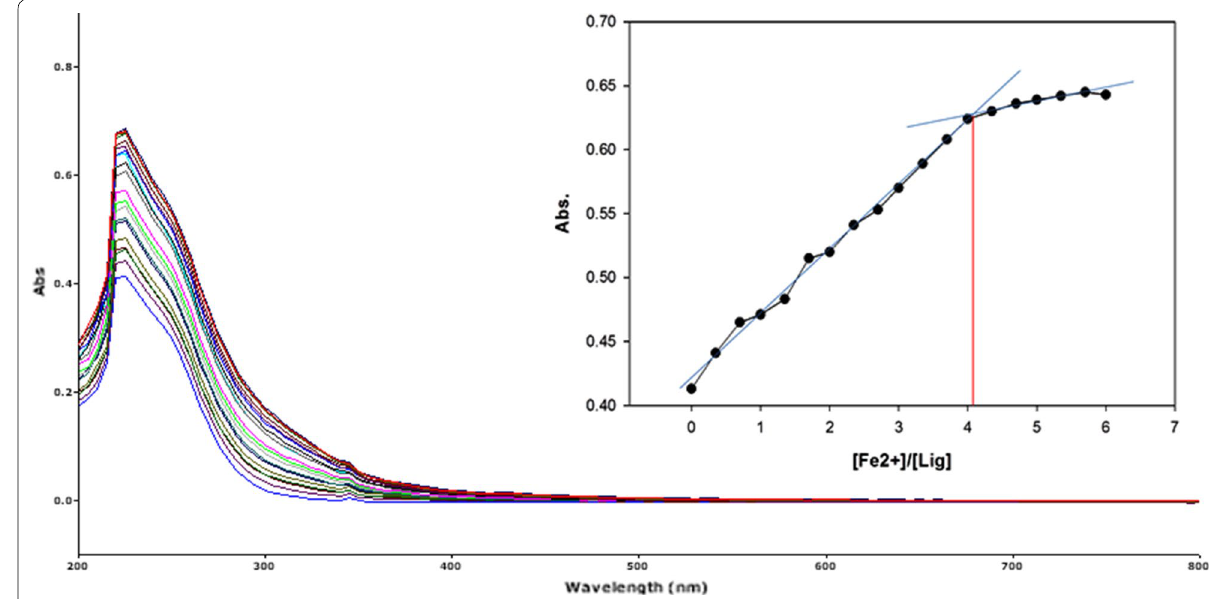
Fig. 9 Titration of isomer 1B vs Fe 2 + ( Inset Binding behavior